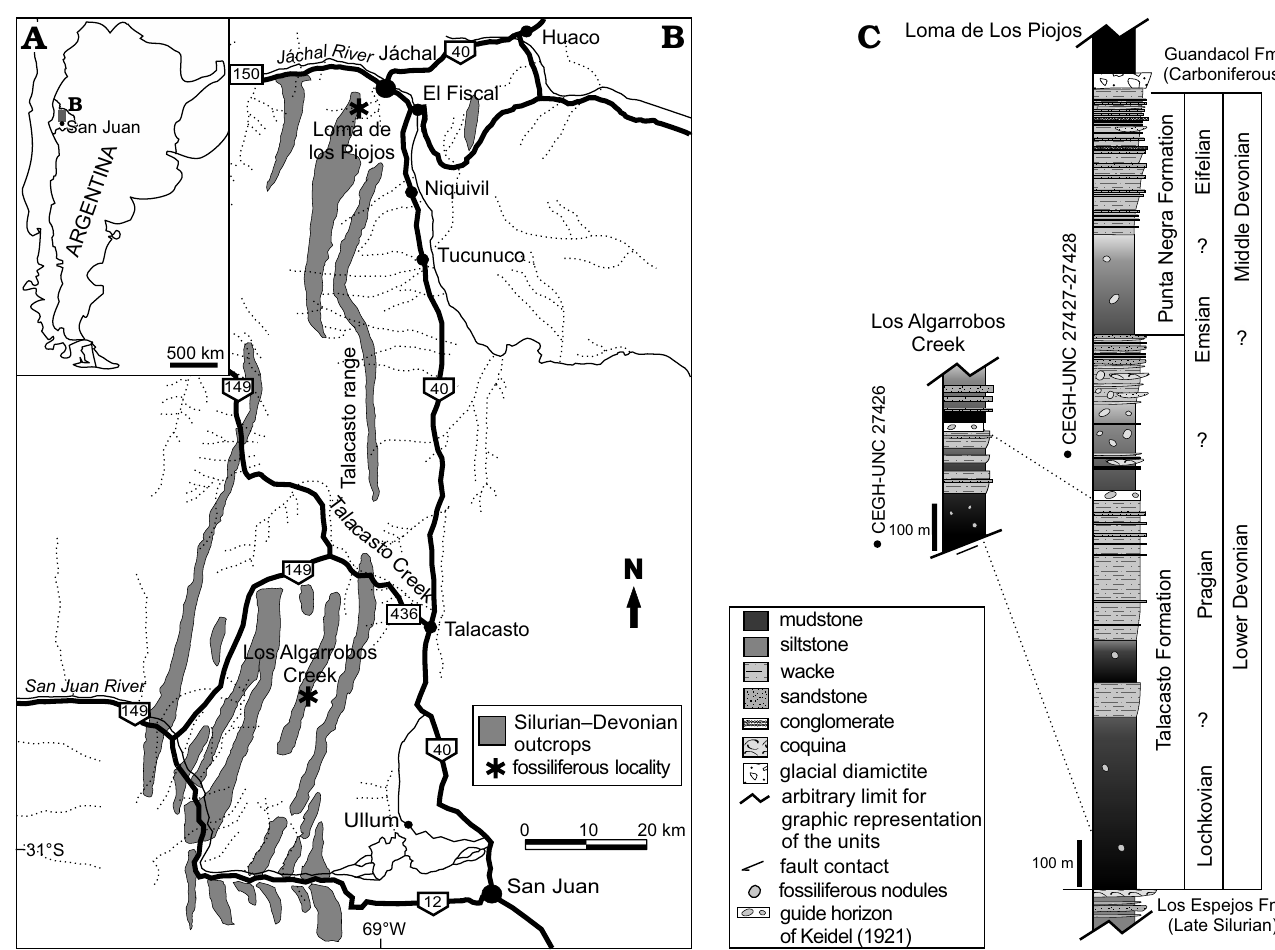
Fig. 1. Location map of the studied fossil localities and middle Palaeozoic outcrops ( A , B ) and stratigraphic sections with fossil occurrences indicated ( C